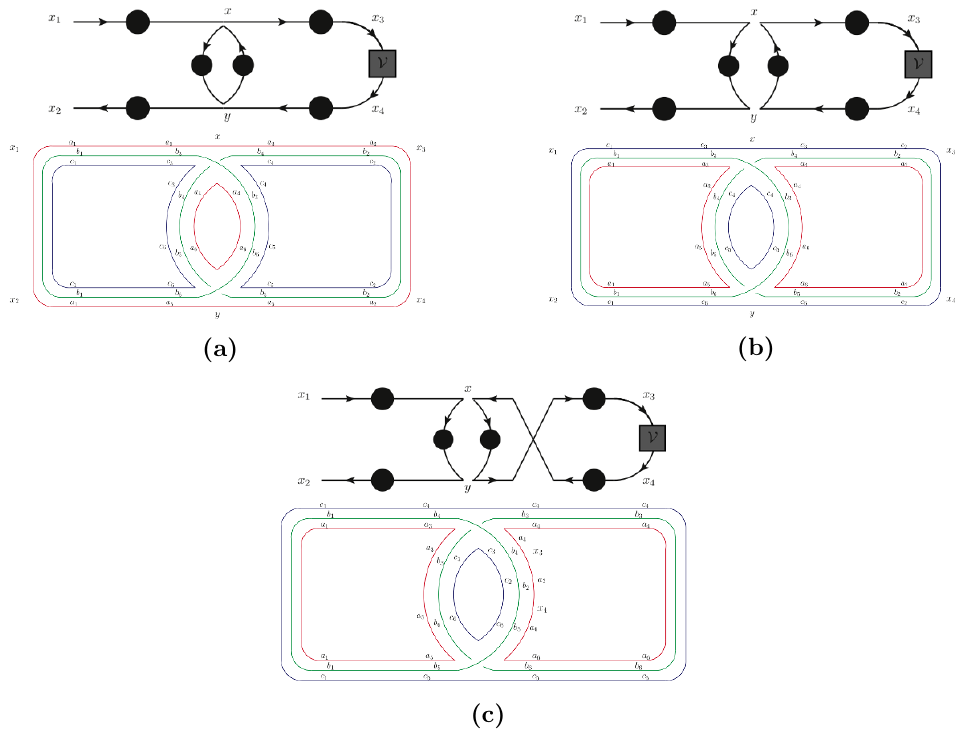
or (cid:21) 2 . 1 2